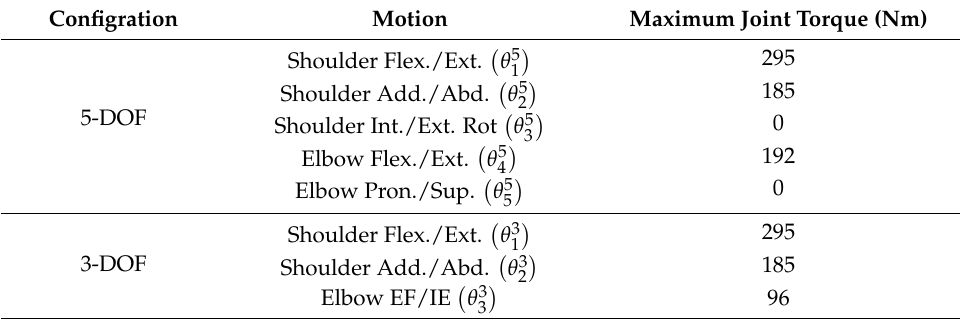
Table 9. Maximum joint torques.